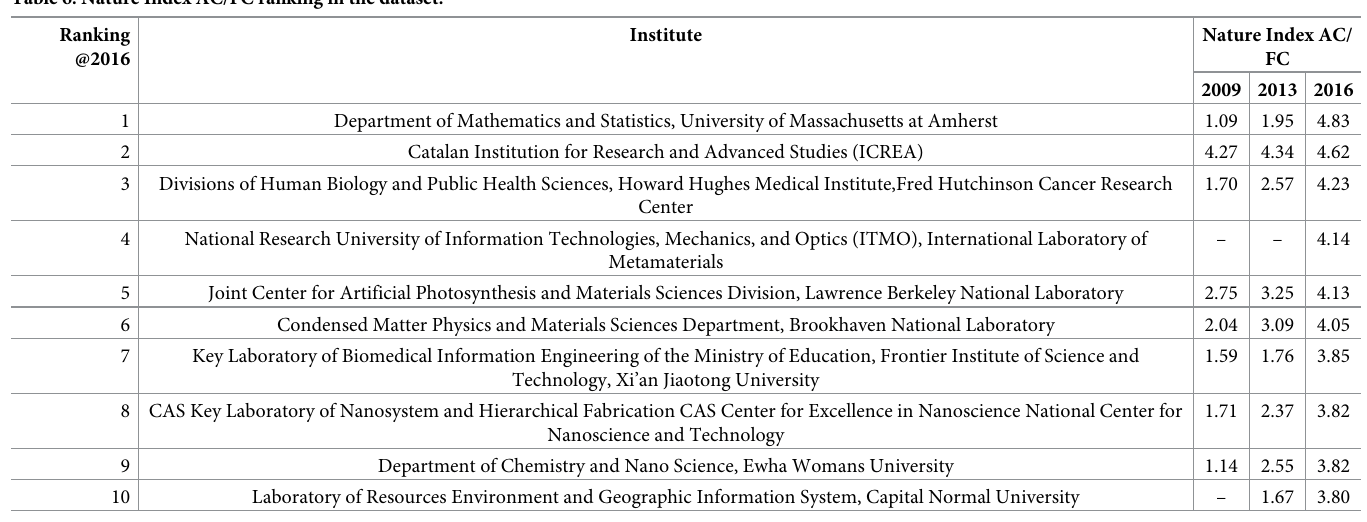
Table 6. Nature Index AC/FC ranking in the